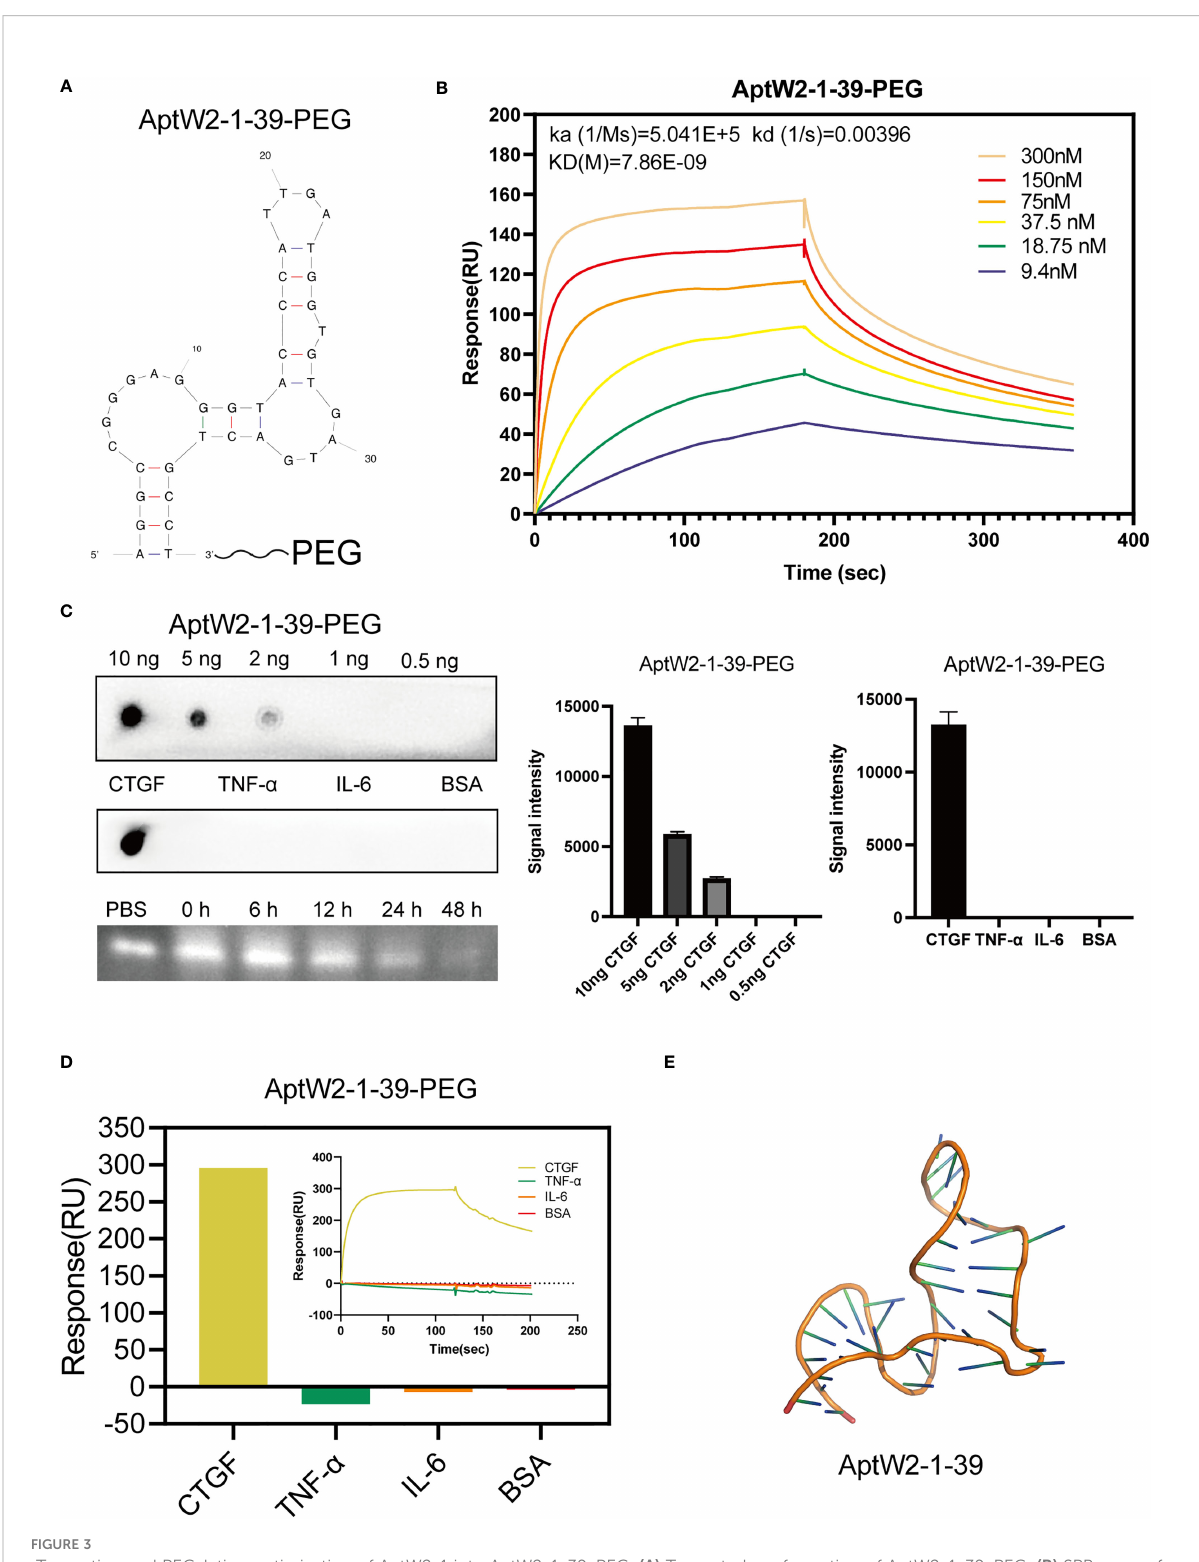
FIGURE 3 Truncation and PEGylation optimization of AptW2-1 into AptW2-1-39-PEG. (A) Truncated conformation of AptW2-1-39-PEG. (B) SPR assay of AptW2-1-39-PEG targeting CTGF. (C) Sensitivity, speci fi city, and stability assays of AptW2-1-39-PEG. (D) SPR assay of AptW2-1-39-PEG with RA-related cytokines TNF- a and IL-6. (E) Tertiary structures of the analog image of